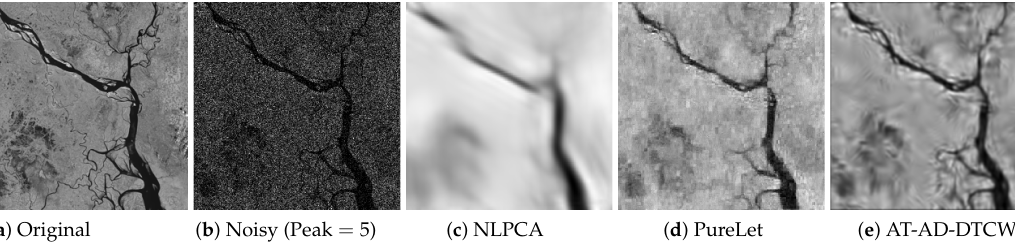
Figure 9. Poisson denoising results on the ‘Padma River’ image by various methods at signal peak =